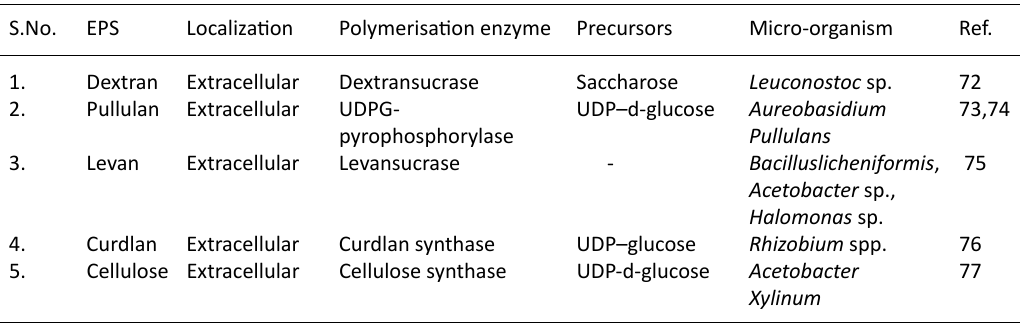
Table 1. List of homopolysaccharides and producing bacteria S.No. EPS Localization Polymerisation enzyme Precursors Micro-organism Ref. Dextran